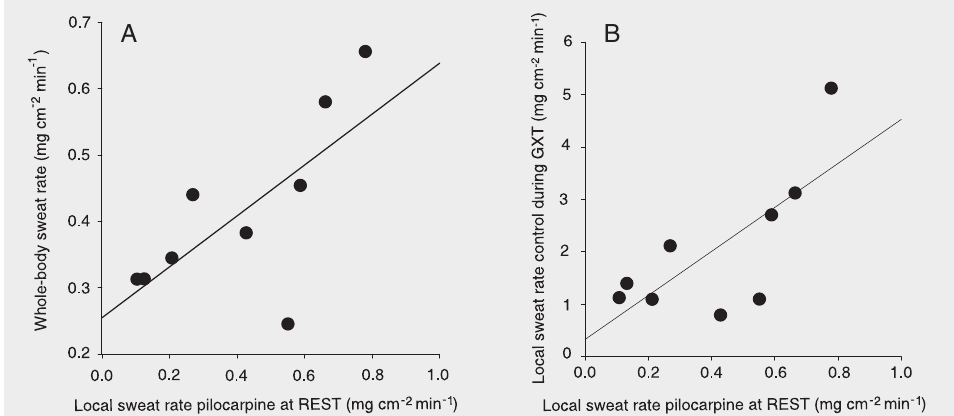
Figure 3. A , Correlation between the local sweat rate on the right forearm induced by pilocarpine at rest (REST) and whole-body sweat rate during the graded exercise test until exhaustion (GXT; r = 0.70, P = 0.03, Pear- son correlation test). B , Correla- tion between the local sweat rate on the right forearm induced by pilocarpine at rest and the local sweat rate on the left forearm (control) during GXT (r = 0.73, P = 0.02, Pearson correlation